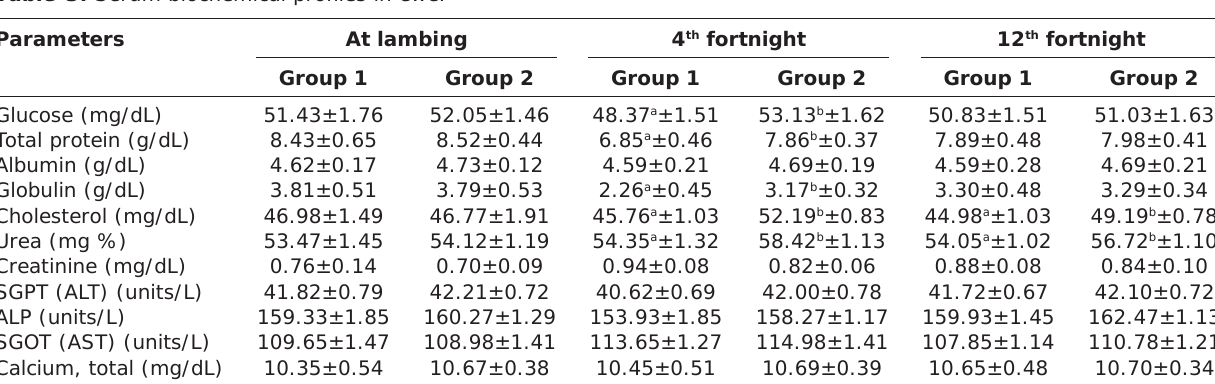
Table-3: Serum biochemical profiles in ewe. Parameters At